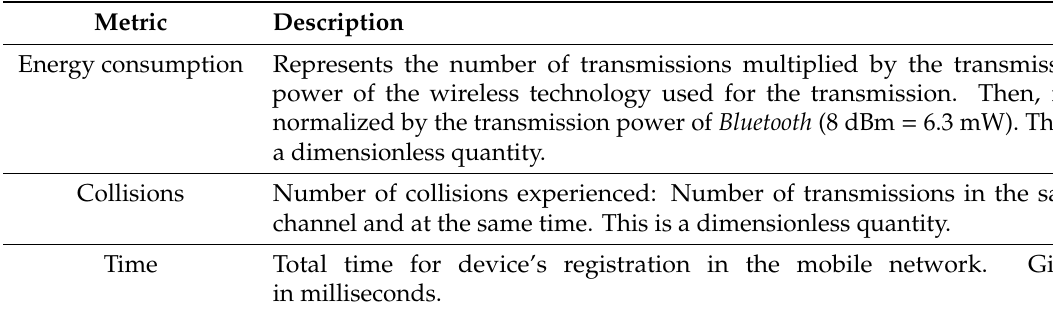
Table 4. Metrics used in the